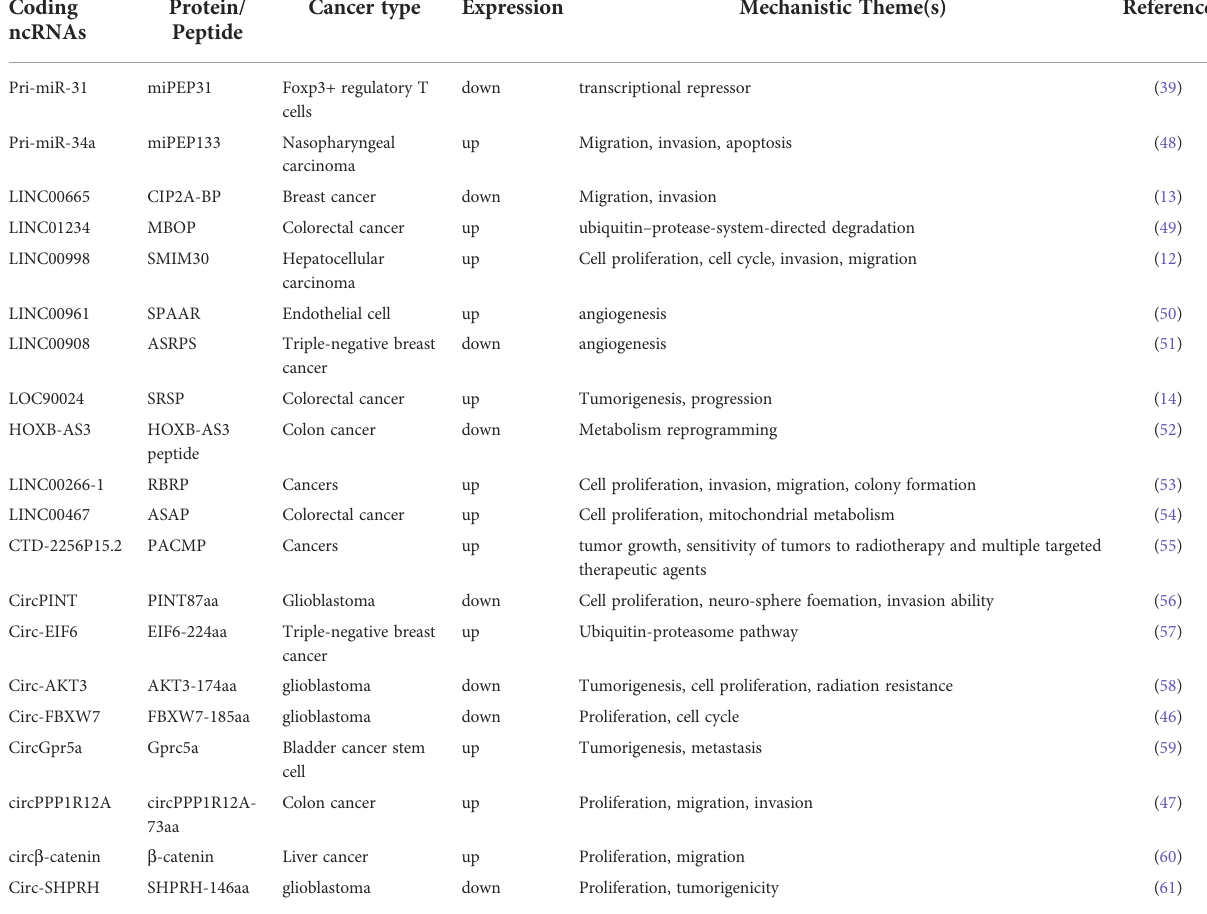
TABLE 2 ncRNAs that can translate proteins or peptides. Coding ncRNAs